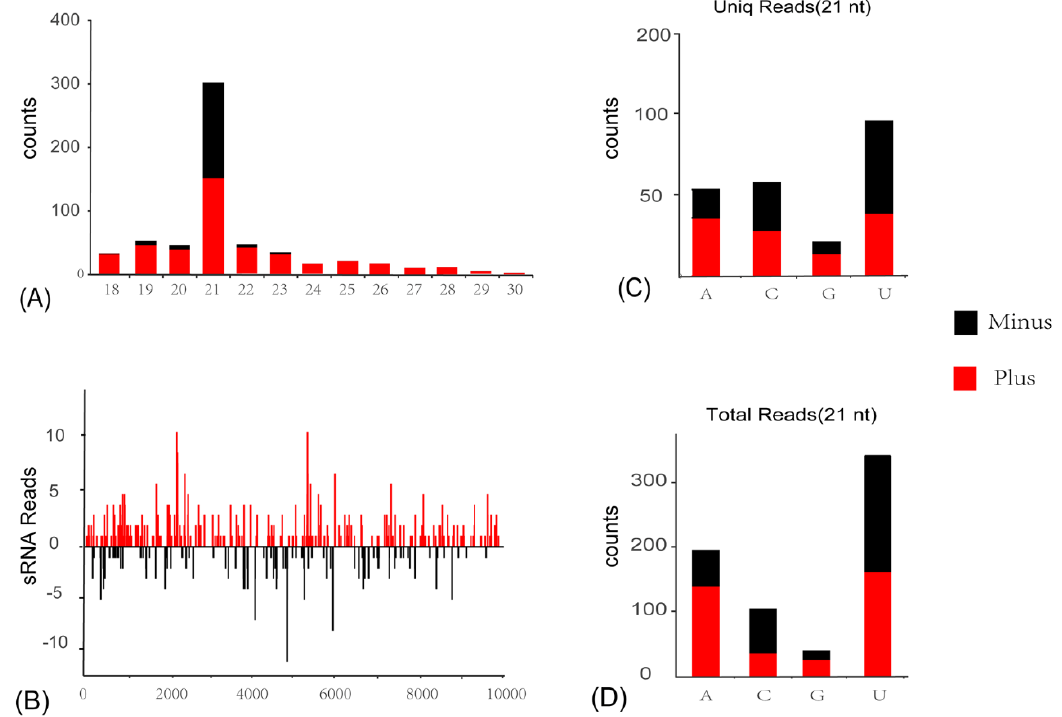
Figure 4. Profiles of virus-derived small interfering RNAs (vsiRNAs) of Cicadella viridis iflavirus 1 (CvIfV1). ( A ) Size distribution of CvIfV1-derived siRNA. ( B ) Distribution of CvIfV1-derived siRNA along the viral genome. ( C , D ) 5 ′ -terminal nucleotide preference of 21-nt long vsiRNAs analyzed by uniq reads ( C ), and total reads ( D ).